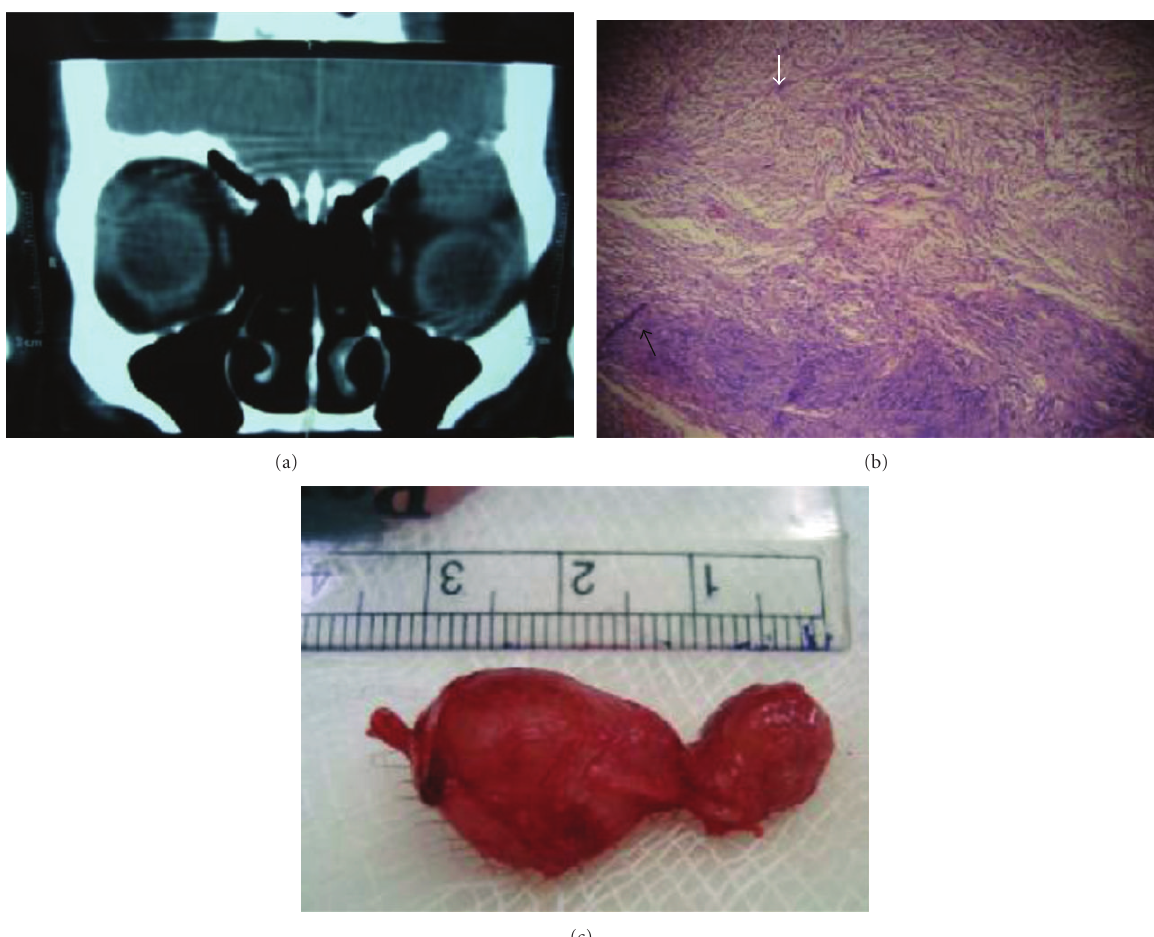
Figure 2: (a) Coronal CT reconstruction shows an extraconal mass causing inferior displacement of left globe with thinning of orbital roof. (b) Histopathological examination shows Antoni A cells (black arrow) and Antoni B cells (white arrow). (c) A bilobed excised tumor of size 3.5cm to 2.5cm with nerve of